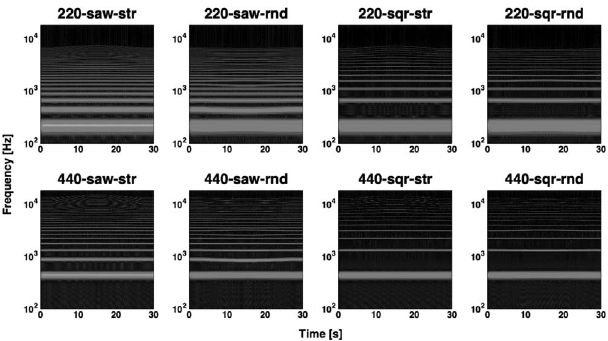
Figure 1. Spectrograms of the 8 stimuli. Stimuli abbreviations: F – spectral shape type (sawtooth or square 0 (220 or 440 Hz) wave) – inharmonicity type (stiff string or